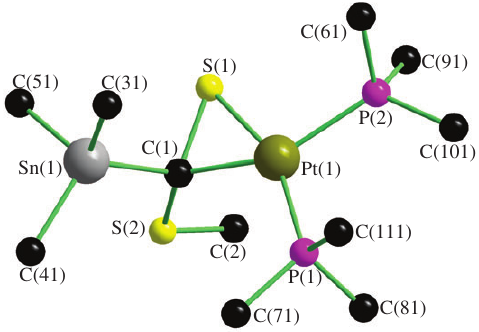
Figure 3 Structure of (PPh omitted for clarity) (Carr et al.,